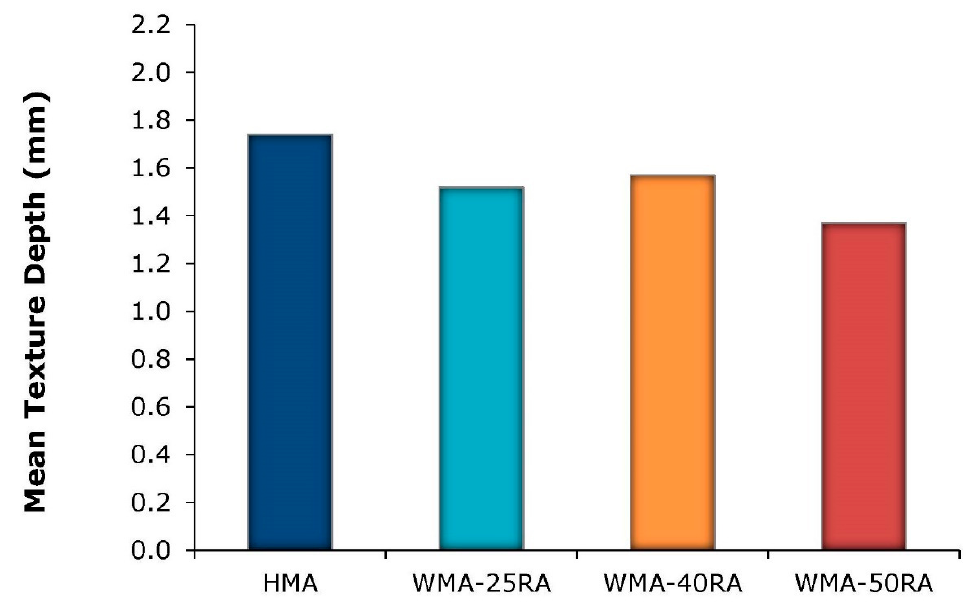
Figure 10. Texture depth results.